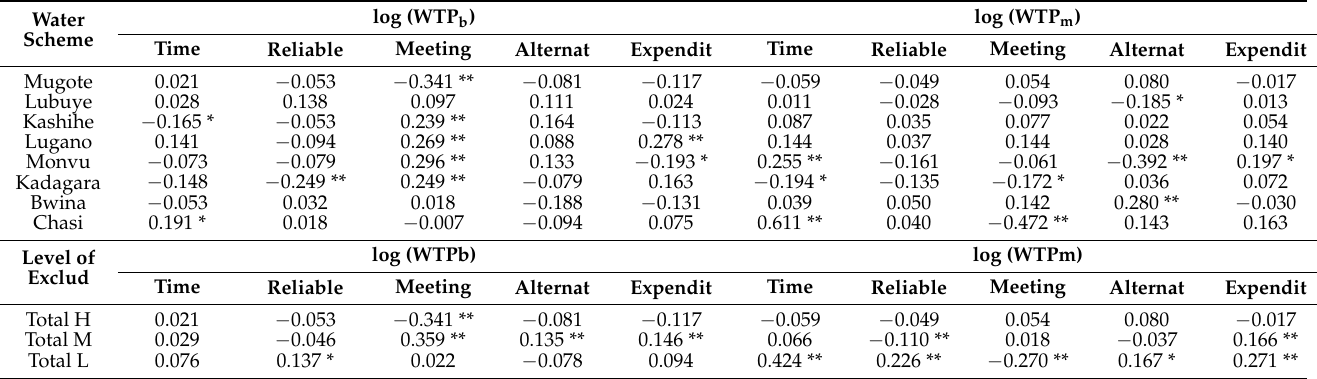
Table 8. Correlation analysis for log (WTP b ), log (WTP m ) classified by water schemes and level of excludability. Water